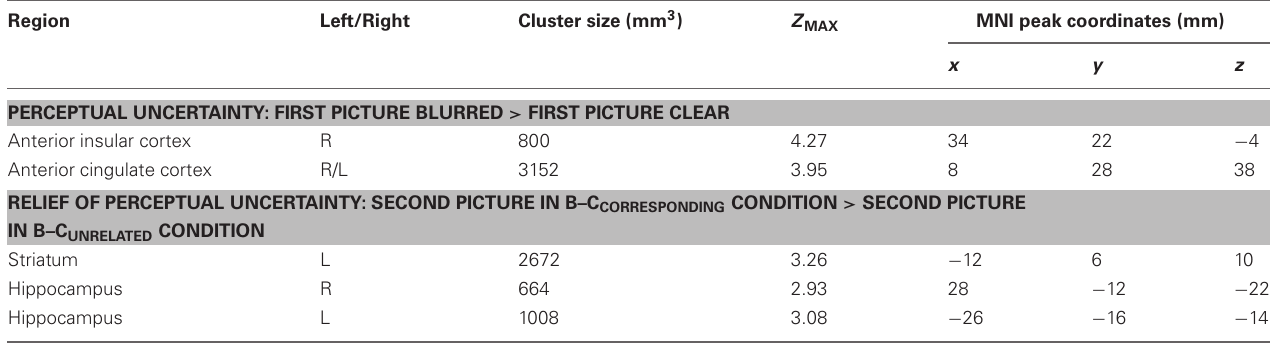
Table 2 | Activation clusters from the ROI analyses. Region Left/Right